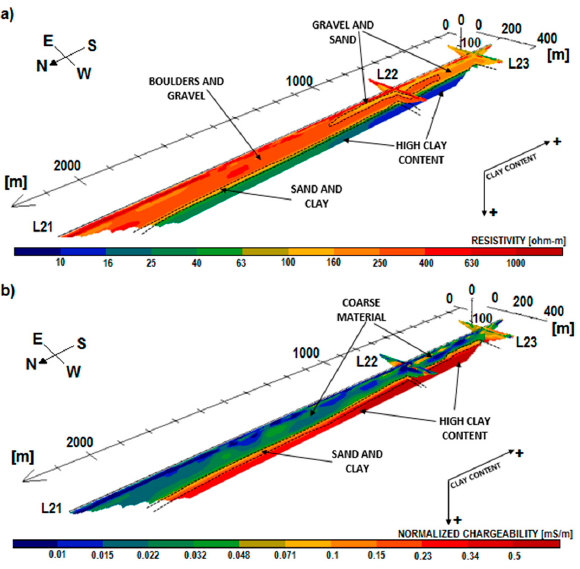
Figure 6. ( a ) Interpretation and 3D visualization of ERT profiles; ( b ) Interpretation and 3D visualization of normalized chargeability profiles. In both cases the lines are 21, 22, and 23.